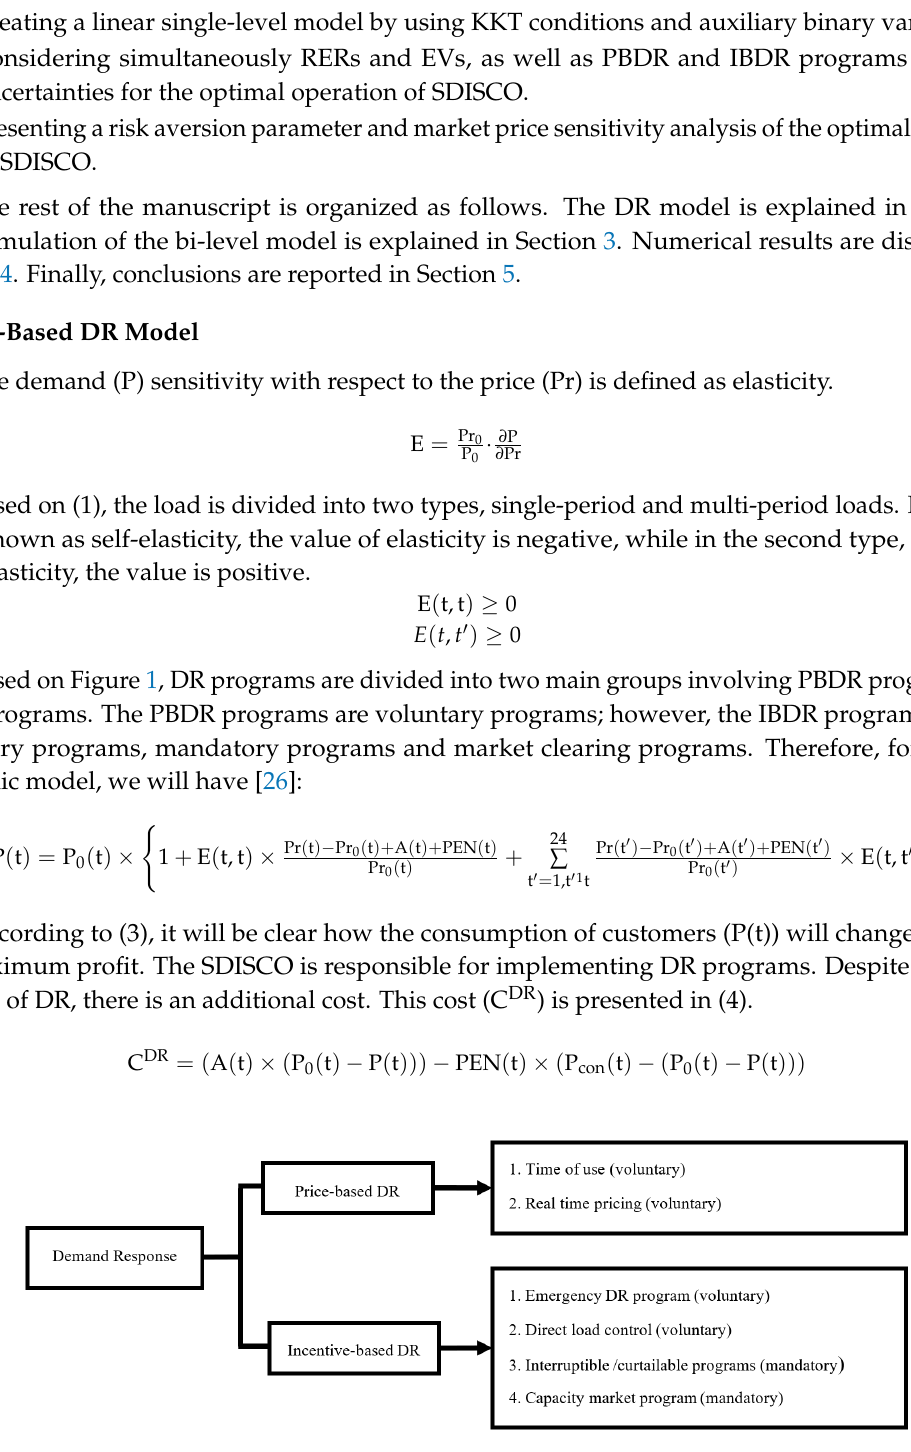
Figure 1. Demand response (DR) programs.